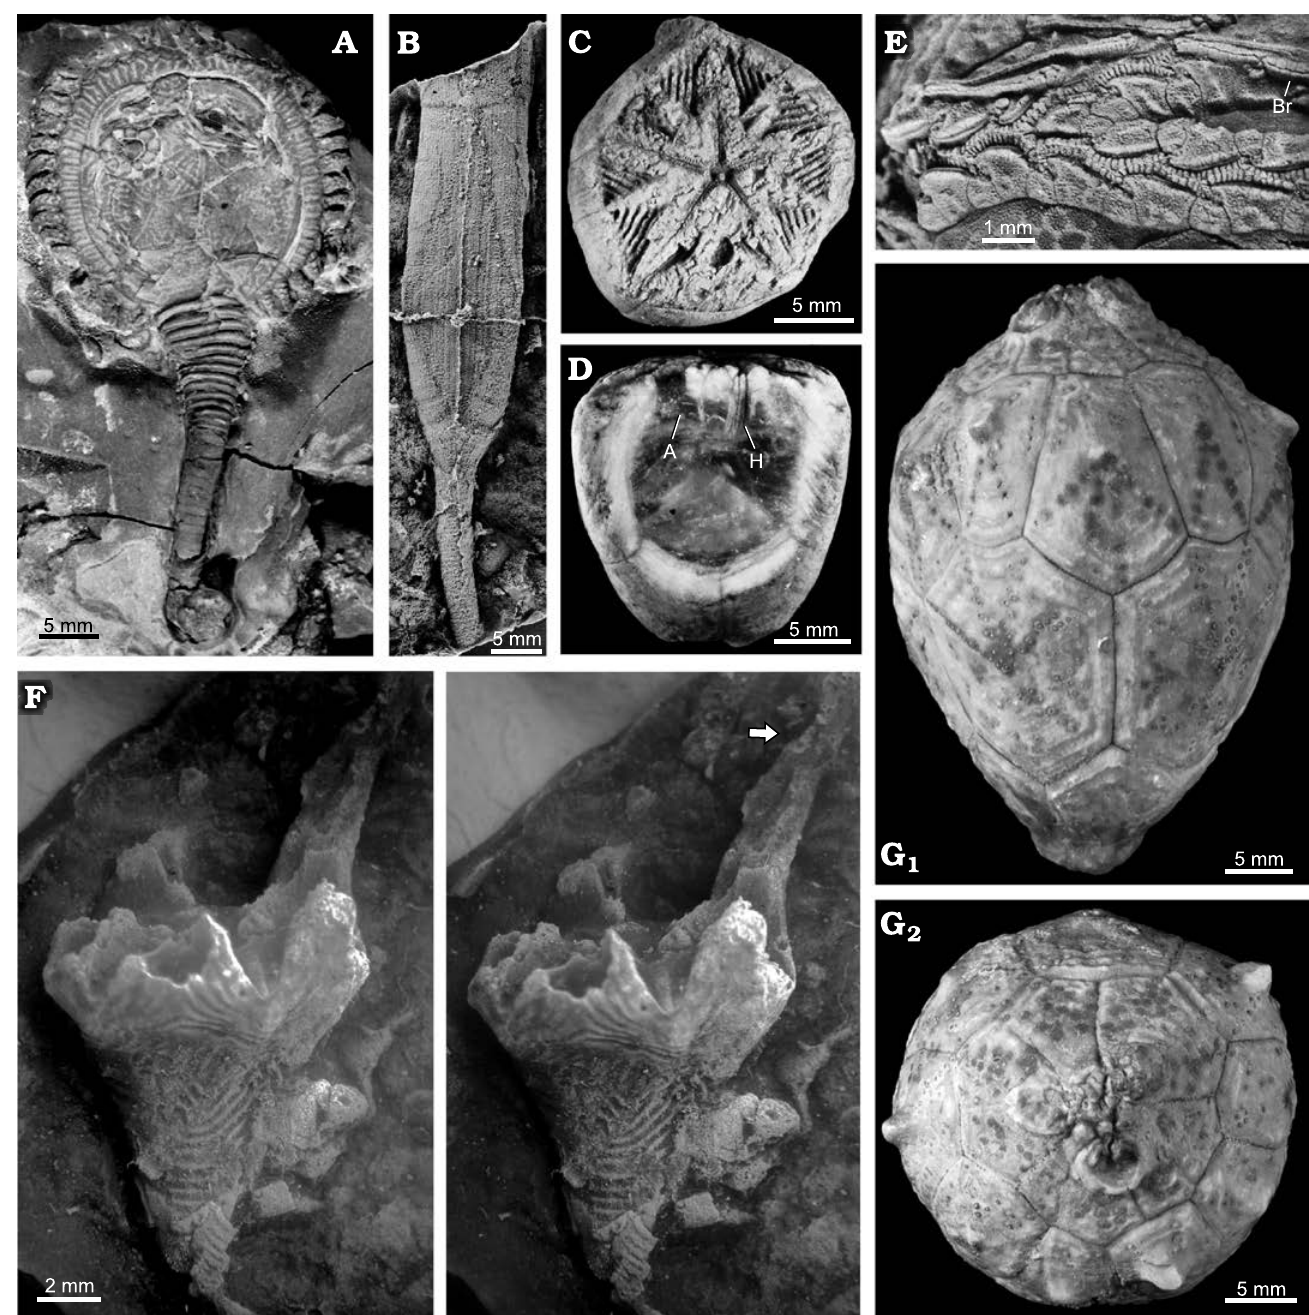
Fig. 6. Examples of pan-dichoporite blastozoans. A . The callocystitid Pseudocrinites bifasciatus Pearce, 1843 (BMNH 40189), Wenlock (Silurian), West Midlands, UK, showing the lenticular theca (above) with peripheral ambulacra, the rapidly tapering proximal stem and more cylindrical distal stem (below) terminating in a root structure. B . The rhombiferid Rhombifera sp. (MPZ 2020/590), Late Ordovician, Zaragoza, Spain, showing the stem attached to the theca, which includes the basal, infralateral and base of the lateral plates (above) and one extensive pectinirhomb. C , D . The fissiculate blastoid Codaster acutus McCoy, 1849, early Carboniferous, Yorkshire, UK. C . Oral view of SM E5400 showing the central mouth, five radiating ambulacra, pectinirhomb-like hydrospires, and circular anus (below). D . Polished lateral view of SM E5398 showing basal and radial plates, anus (A) and very thin hydrospire folds (H). E . One branched ambulacrum of the callocystitid Callocystites jewetti Hall, 1852 (ROM 991N), Wenlock (Silurian), Ontario, Canada, showing the ambu- lacral structure. The mouth is to the left. Brachiole facets (lower branch) are each on a smaller adoral and larger aboral floor plate. Biserial brachioles alternate along the ambulacrum (Br), so main ambulacral axis has double biserial floor plates. F . Stereo images of the coronate Cupulocorona rugosa Donovan and Paul, 1985 (NMW 2013.8G.65i), Late Ordovician, Carmarthen, Wales, showing theca shape and extensive coronal processes (arrow). Top of the small basal plate is displaced. The rest of the theca up to the tip of the coronal process is formed by the “radial” plates. Erect ambulacra arose within the valleys between the coronal processes. G . The hemicosmitoid Hemicosmites extraneus Eichwald, 1840 (GIT 398–898), Late Ordovician, Madise, Estonia. Lateral view (G 1 ) showing, from below, basal, infralateral, lateral, and radial plate circlets. Cryptorhomb pores can be seen in the infralateral and lateral plates. Oral view (G 2 ) showing three large facets for erect